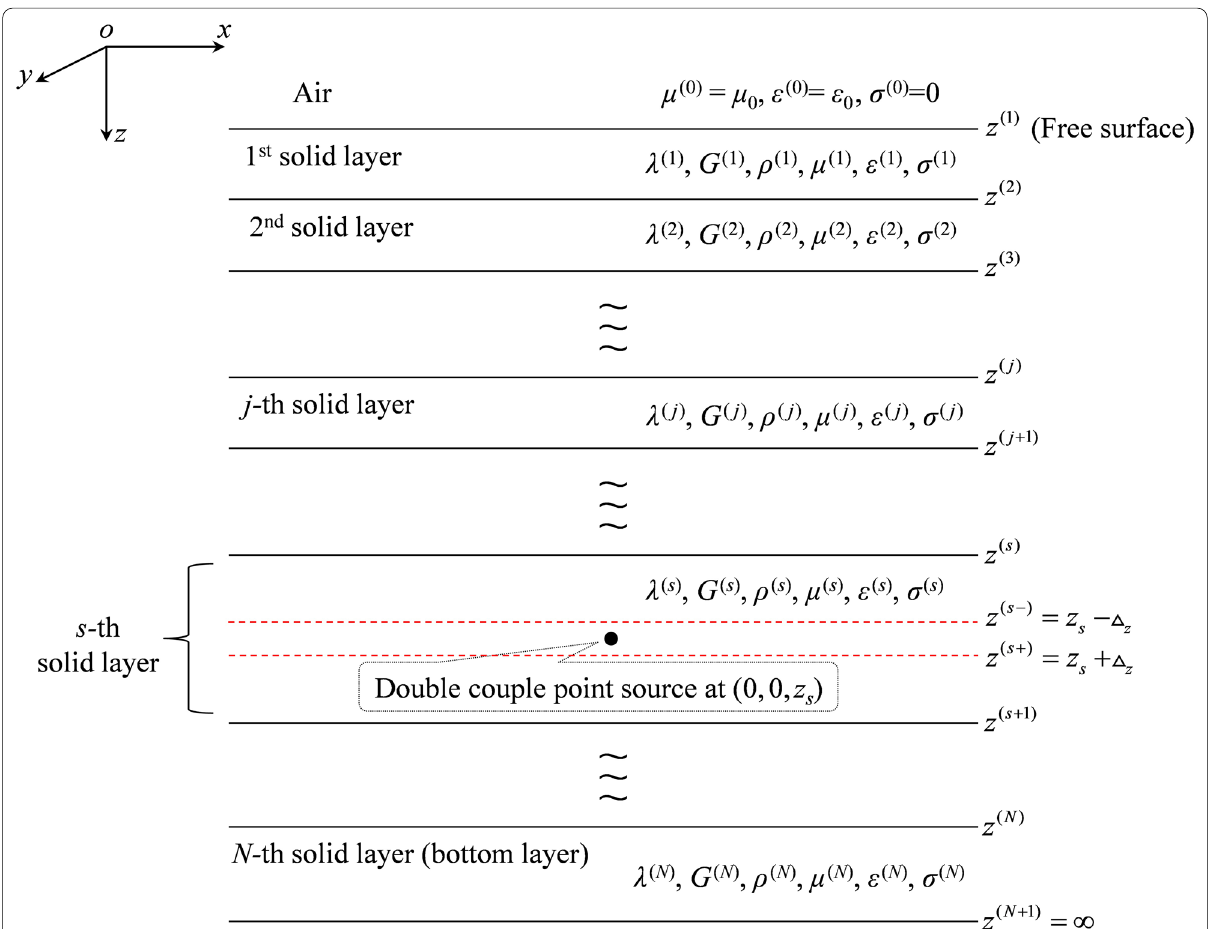
Fig. 1 A multi‑layered media with a double couple point source in the s th